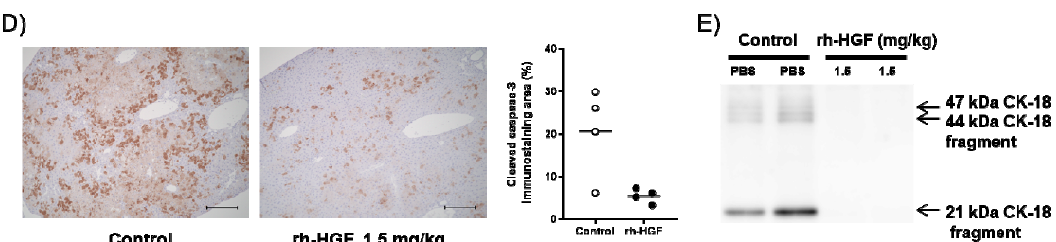
ff ects of rh-HGF in an anti-Fas antibody-induced mouse acute liver failure (ALF) Figure 2. Effects of rh-HGF in an anti-Fas antibody-induced mouse acute liver failure (ALF) model. Figure 2. E